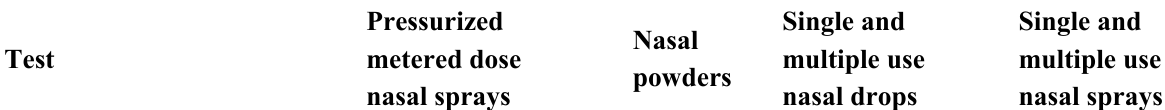
Table 2. Tests recommended for nasal drug product characterization/development studies by the FDA and the